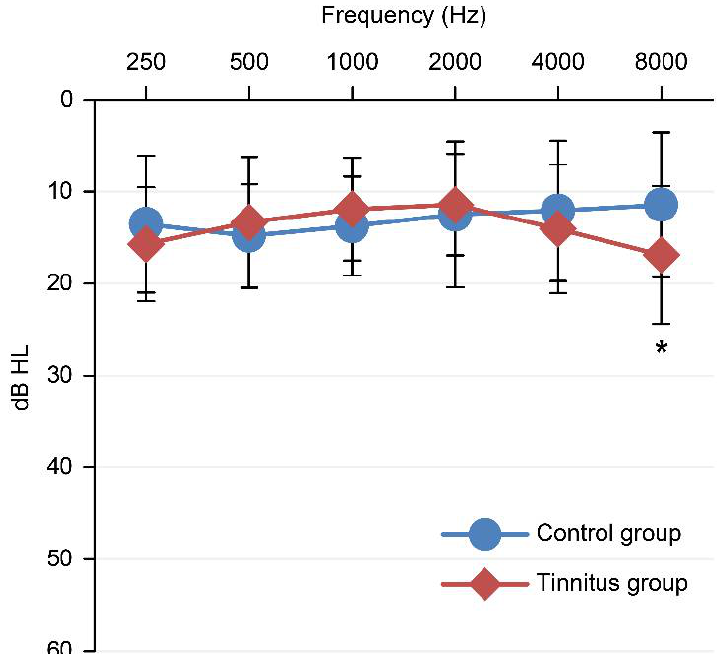
Figure 1. Hearing threshold curves of the two groups of test ears. Error bars show 95% confidence intervals; * p < 0.05.